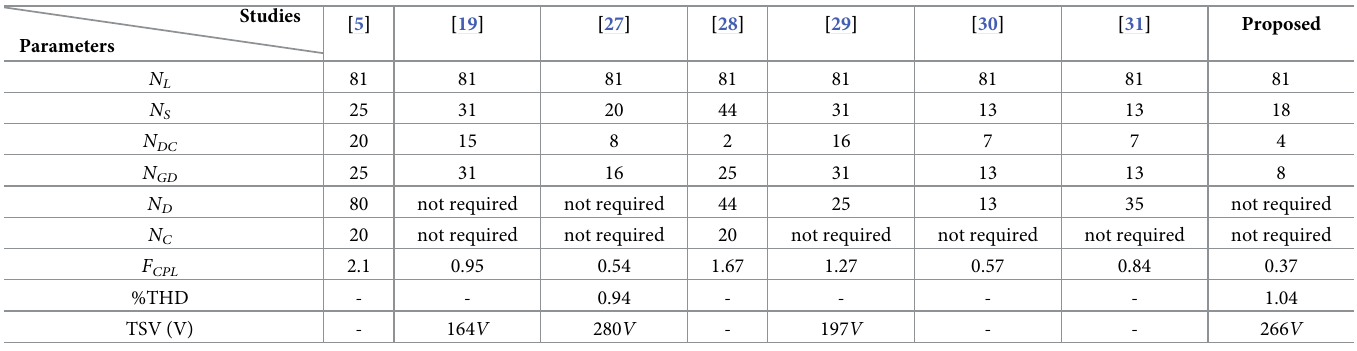
Table 3. Comparison between various MLI topologies. Parameters